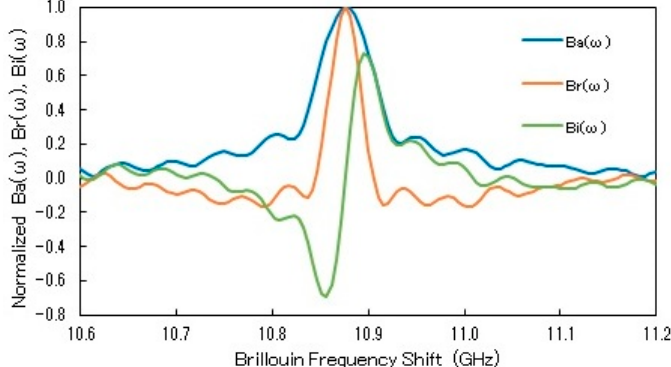
Figure 5. Comparisons of experimentally obtained spectra, B a ( ω ) , B r ( ω ) and B i ( ω ) , drawn by blue, orange and green curves, respectively; T L = 20 ns, T S = 2 ns, T I = 0.5 ns.